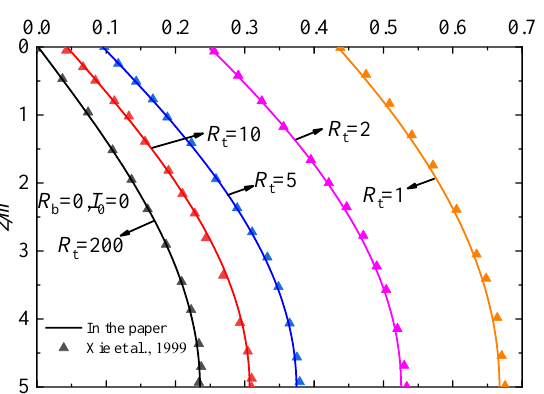
Figure 3. The verification of the single-sided impeded drainage boundaries at 500 days (i.e., corre- sponding to T = 0.6912).